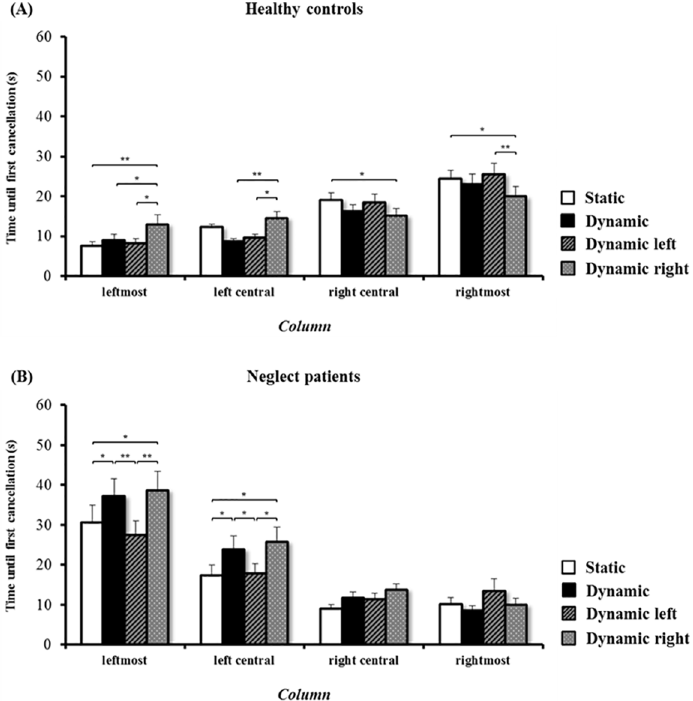
Fig 2. Mean time until first target cancellation in healthy controls and patients. Mean time until first cancellation in healthy controls (A) and neglect patients (B), in the four conditions (static, dynamic, dynamic left, and dynamic right), and in the respective columns: leftmost, left-central, right-central, and rightmost. Error bars represent the standard error of the mean (SEM). Asterisks depict significant post-hoc tests ( * p <